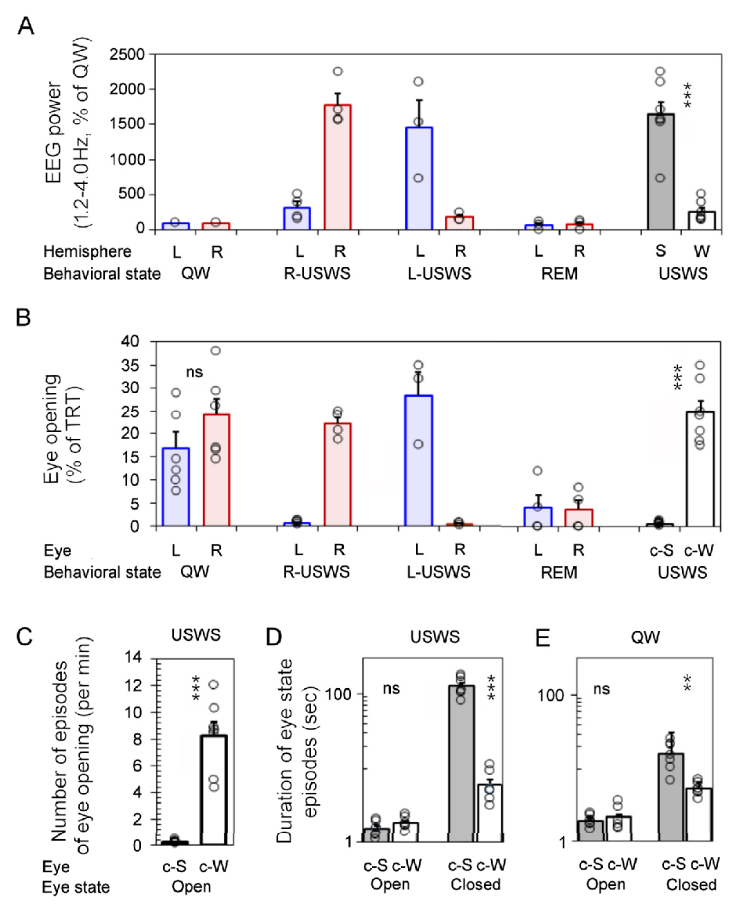
Fig 3. Association between behavioral state and eye state in fur seals in water. (A) Standardized EEG power in the range of 1.2–4.0 Hz in two cerebral hemispheres (shown as percent of the average power in QW in the corresponding hemisphere) during QW, R-USWS, L-USWS, USWS (R-USWS and L-USWS) and REM sleep in 2 fur seals. (B) Total amount of the open state of the left and right eye during waking and sleep states. (C-E) Number and duration of the episodes of eye opening and closure during USWS (C, D) and QW (E). S and W correspond to sleeping and waking hemispheres. L and R correspond to left and right hemispheres or eyes. c-S and c-W correspond to which eye is contralateral to the sleeping and waking hemisphere, respectively. During QW the eyes were classified as c-S or c-W based on the adjacent USWS. Open circles represent the means for individual USWS, QW and REM sleep episodes recorded in 2 seals (S2 Table). Bars are grand average (mean) ± SEM for all episodes of QW and USWS. The difference between the power and the state of the eye was tested for all 7 episodes of USWS and 7 adjusted episodes of QW recorded in seals A and B. �� , ��� Statistical significance (the paired T-test) with p < 0.01 and < 0.001, respectively. ns– difference was not significant (p > 0.05; S1 File).